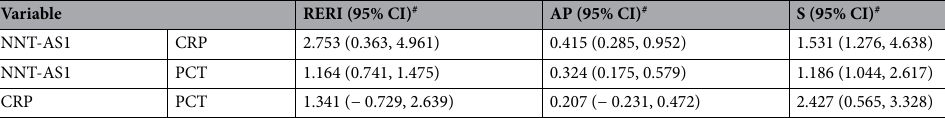
Table 6. Additive interaction of related indicators. # Adjusting the fever days, hospital stay days, abnormal signs of lungs, IgA,